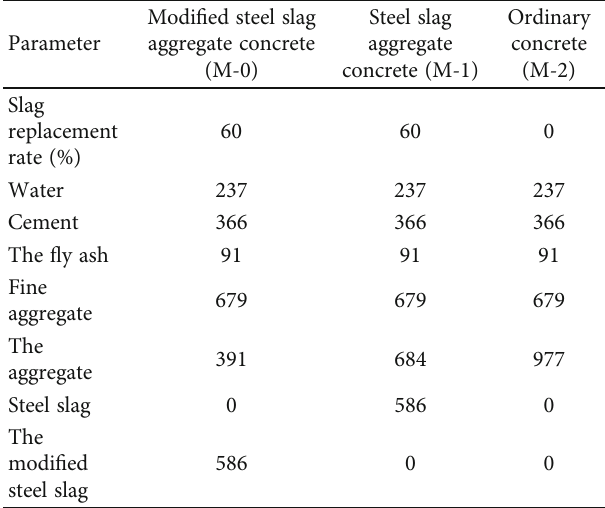
Table 4: Concrete mix proportion design (kg/m 3 ).